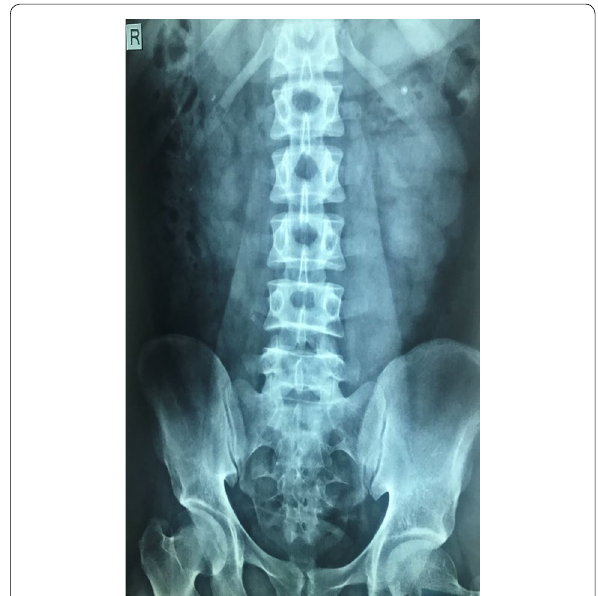
Fig. 3 KUB radiograph pre ESWL, bilateral small renal stone